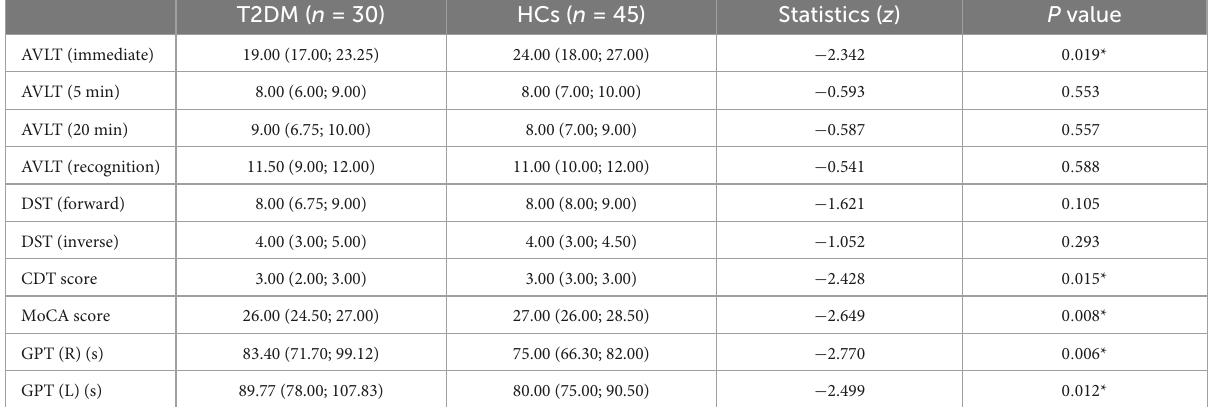
TABLE 2 Neuropsychological result of two